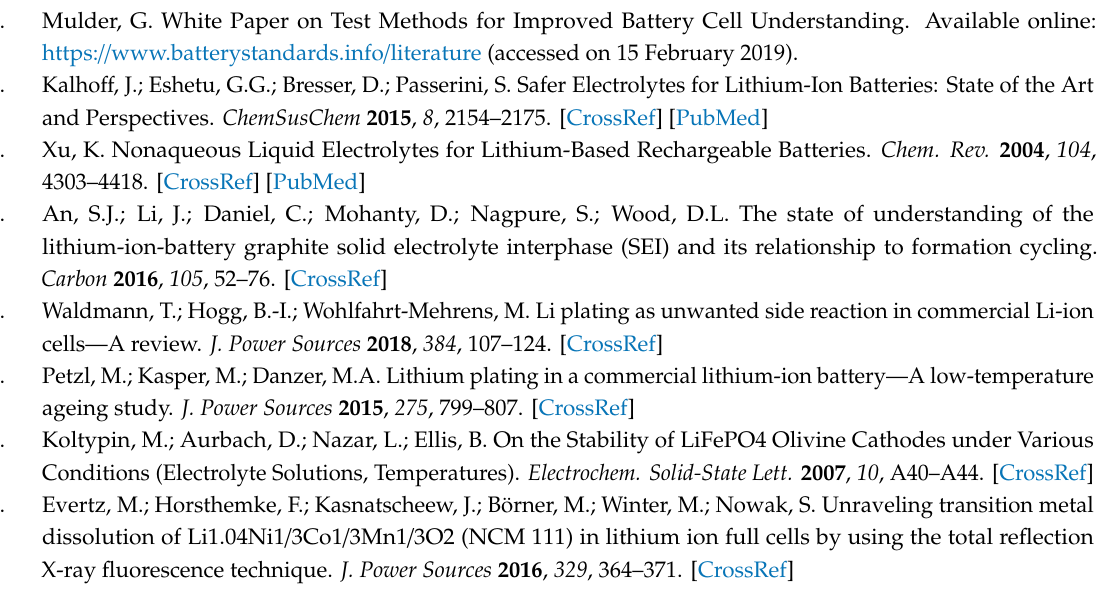
Figure S1. Results of 16 Ah soft prismatic cells cycled at di ff erent temperatures: 5 ◦ C (blue), 25 ◦ C (green) and 45 ◦ C (red) at 1 C discharge rate and 0.3 C (circle), and 2 C (square) in charge. Table S1. Summary of measurements performed in di ff erent stack´s positions. Figure S2. SEM images of LFP electrode extracted from di ff erent parts of the stack of Cell A. Figure S3. SEM images of LFP samples. Figure S4. EDX spectra of aged cathodes. Figure S5. Figure S7. SEM of separators from Fresh Cell, Cell A and Cell B. Figure S8. Voltage profile of the first cycle of a pristine cathode. Figure S9. Comparison of first de-lithiation of aged cathode in freshly re-assembled half-cells. Table S2. C-rate test protocol for half-cells with aged cathodes. Figure S10. Examples of Rietveld refinement of XRD patterns of aged cathodes. Figure S11. XRD patterns (focus on 00l peak at 26.8 ◦ ) of pristine, fresh and aged